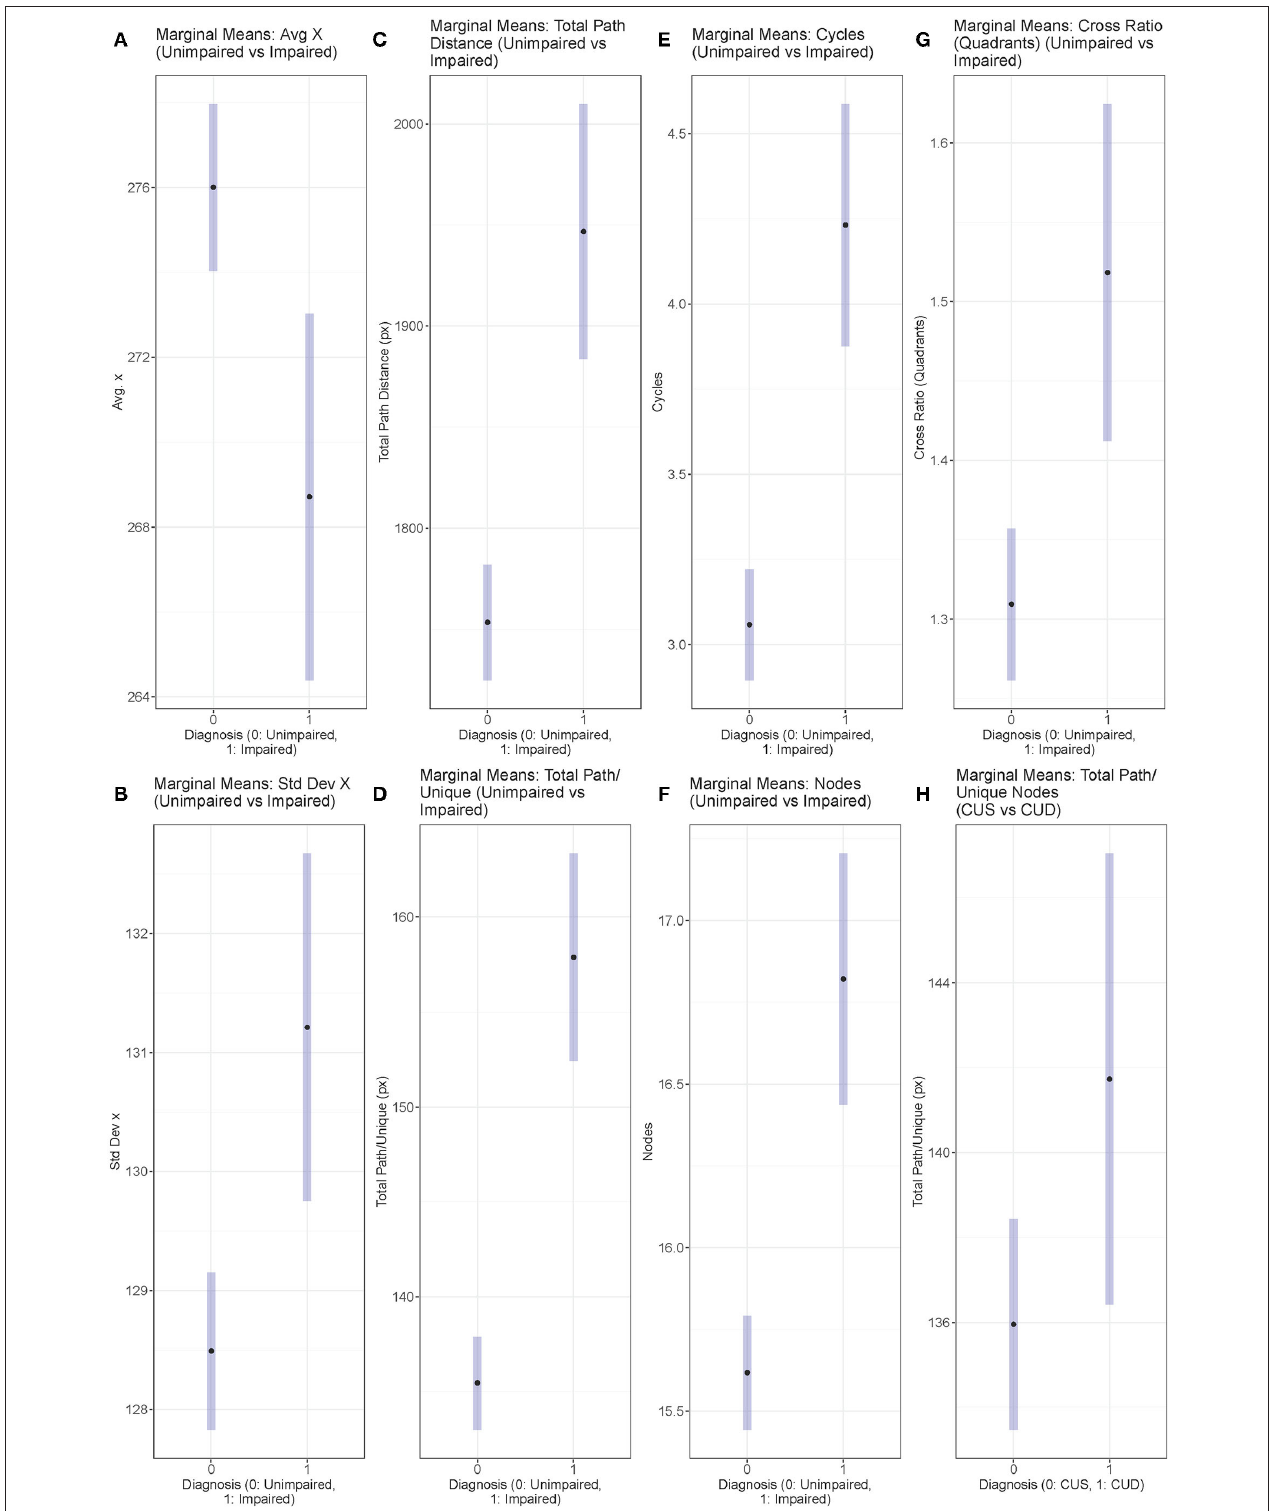
FIGURE 2 | Marginal Means Plots displaying the marginal means for all features with significant results from both sets of ANCOVAs (A–G) Unimpaired vs. Impaired, and (H) CUS vs. CUD. Marginal means are estimated using model parameters, holding Age, Education, Gender, and Unique Nodes constant.